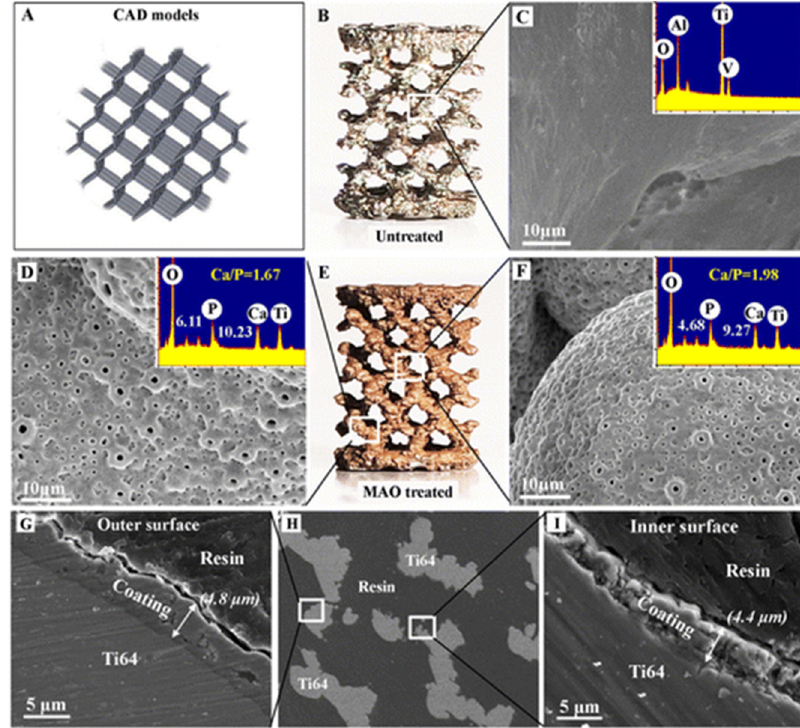
Figure 7. Surface characteristics of the porous Ti64 scaffold before and after micro arc oxidation (MAO) treatment. ( A ) CAD model of multiplanar hexagonal unit cell structures; macroscopical view of the untreated scaffold ( B ). MAO treated scaffold ( C ) and the MAO ‐ treated scaffold at the ( D ) outer surface ( E ); scanning electron microscopic (SEM) images and EDS analysis (inset image) of the untreated scaffold ( F ) central surfaces. Cross ‐ sectional image of the MAO coatings at the ( G ) external and ( I ) internal surface of the scaffold and ( H ) preliminary image shows the positions of the observed struts of the scaffold [121]. Reprinted with permission from Ref. [121]. Copyright 2016, American Chemical Society.